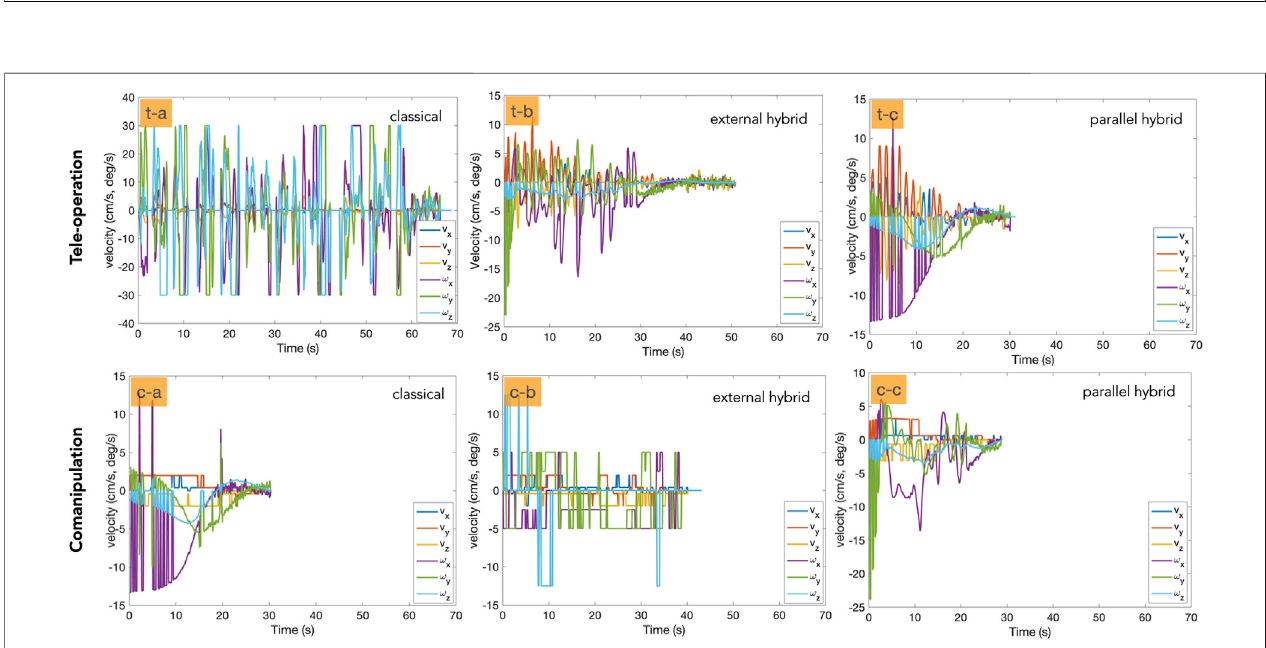
FIGURE11| Illustrationofthevelocitytwistinvolvedineachcontrolmode.The fi rstrowshowsthetele-operationmodeandthesecondrowcolumnrepresentsthe comanipulation one.